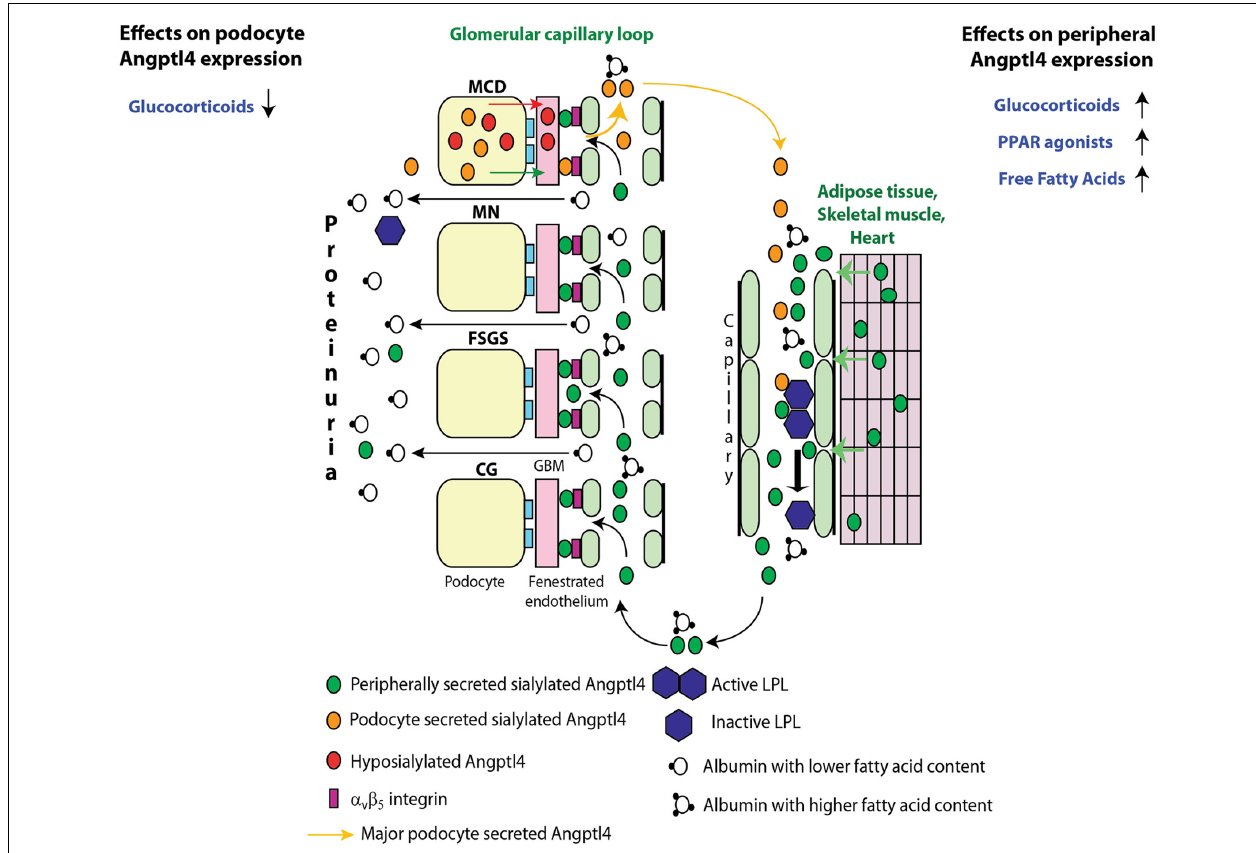
adipose tissue) secrete the circulating, sialylated form of Angptl4. Treatment with glucocorticoids, PPAR agonists and free fatty acids increase peripheral organ Angptl4 secretion. Circulating Angptl4 binds to glomerular endothelial α v β 5 integrin to reduce proteinuria, or inactivates endothelium bound lipoprotein lipase (LPL) in skeletal muscle, heart and adipose tissue to reduce hydrolysis of plasma triglycerides to free